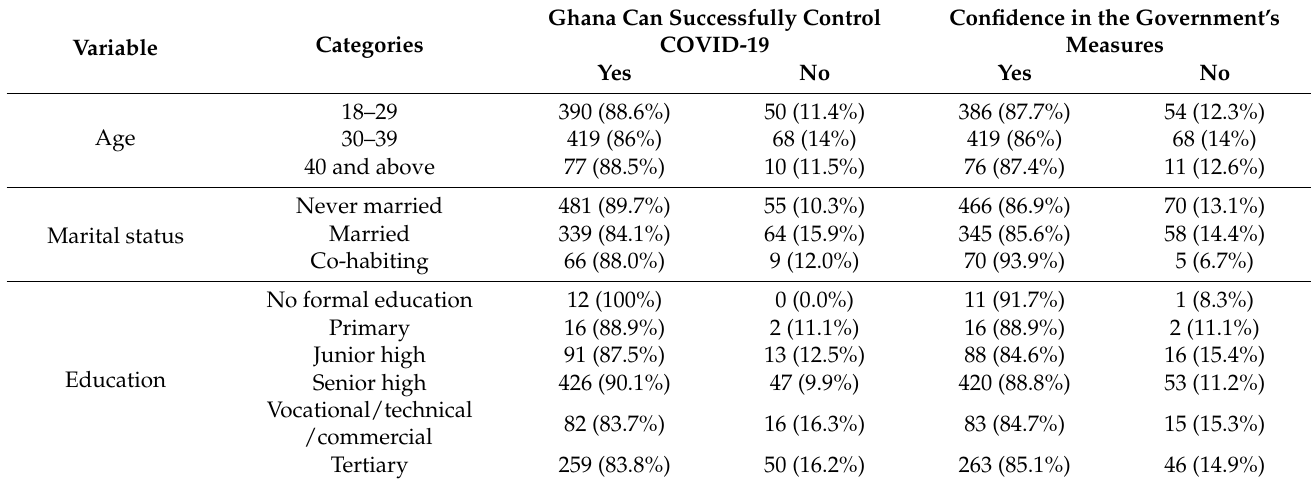
Table 4. Attitudes of participants by socio-demographic